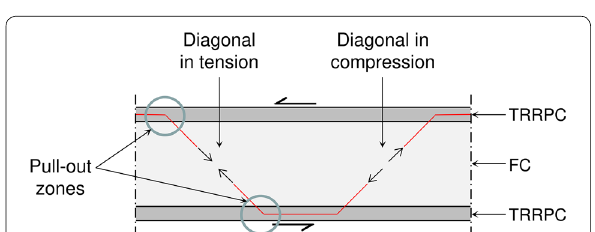
Fig. 4 Schematic of load transfer to the connector in a sandwich element.